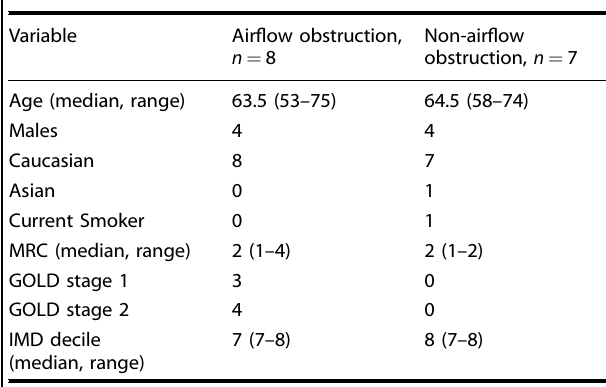
Fig. 1 Recruitment fl ow diagram. Indicated is the recruitment of subjects in the ASSIST study. The diagram indicates the number of GPs patients were recruited from, number of patients identi fi ed by the algorithm, number invited to attend, number responded and number recruited. The purposeful selection of patients for the qualitative arm of the study is also indicated. Table 1. Patient